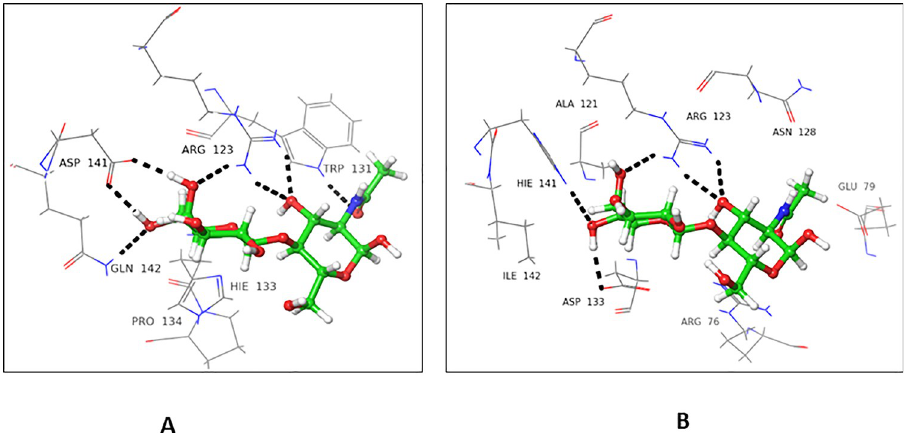
Fig 2. NLC Interactions with (A) native, and (B) mutated